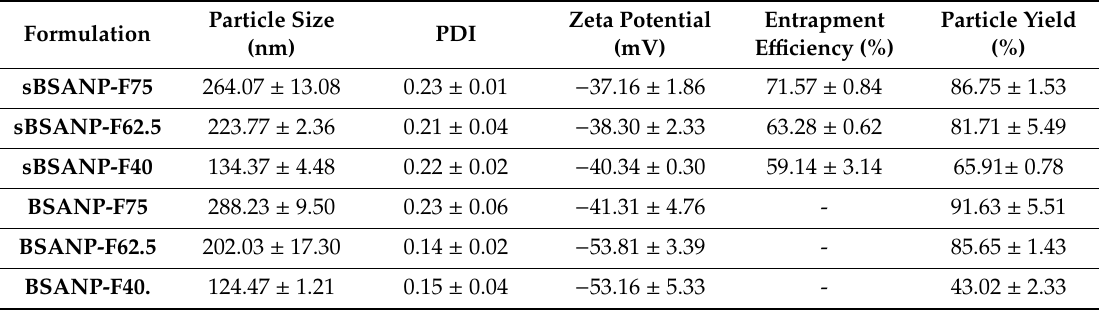
Table 1. Characterization of bovine serum albumin nanoparticles (BSANPs) with or without SN-38 in terms of particle size, polydispersity index (PDI), zeta potential, entrapment e ffi ciency, and particle yield. Zeta Potential Particle Size PDI Formulation (nm) sBSANP-F75 sBSANP-F62.5